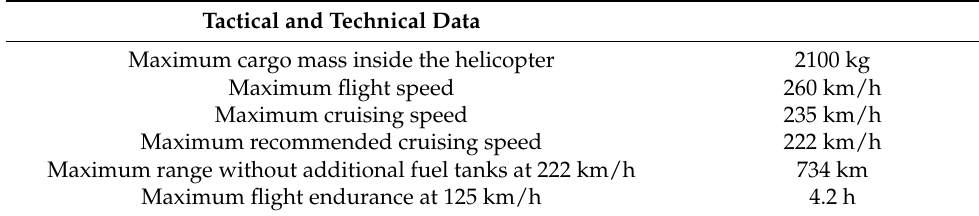
Table 4. Basic tactical and technical data of the W-3RM Anaconda